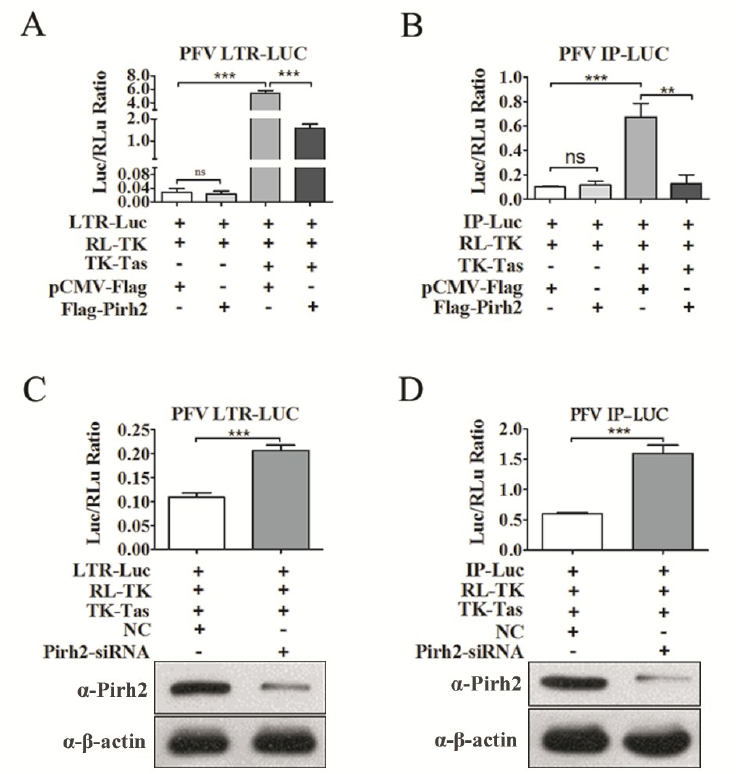
Figure 3. Pirh2 negatively regulates the Tas-dependent transcriptional activation of PFV LTR and IP. ( A , B ) Overexpressing Pirh2 down-regulates Tas-dependent transcription of the PFV LTR and IP. 293T cells were transfected with LTR-Luc (40 ng) ( A ) or IP-Luc (20 ng) ( B ) in the presence or absence TK-Tas (50 ng) combined with Flag-Pirh2 (400 ng) or pCMV-Flag (400 ng) (as a control); RL-TK was used to normalize transfection efficiency. At 48 h post transfection, luciferase activities were measured according to the manufacturer’s instructions; ( C , D ) Knockdown of Pirh2 with its specific siRNA up-regulates Tas-dependent transcription of the PFV LTR and IP. 293T cells were transfected with LTR-Luc ( C ) (40 ng) or IP-Luc (20 ng) ( D ) in the presence TK-Tas (50 ng) combined with Pirh2-siRNA (20 pmol) or nonsilencing siRNA NC (20 pmol) (as a negative control); RL-TK (50 ng) was used to normalize transfection efficiency. At 48 h post transfection, luciferase activities were